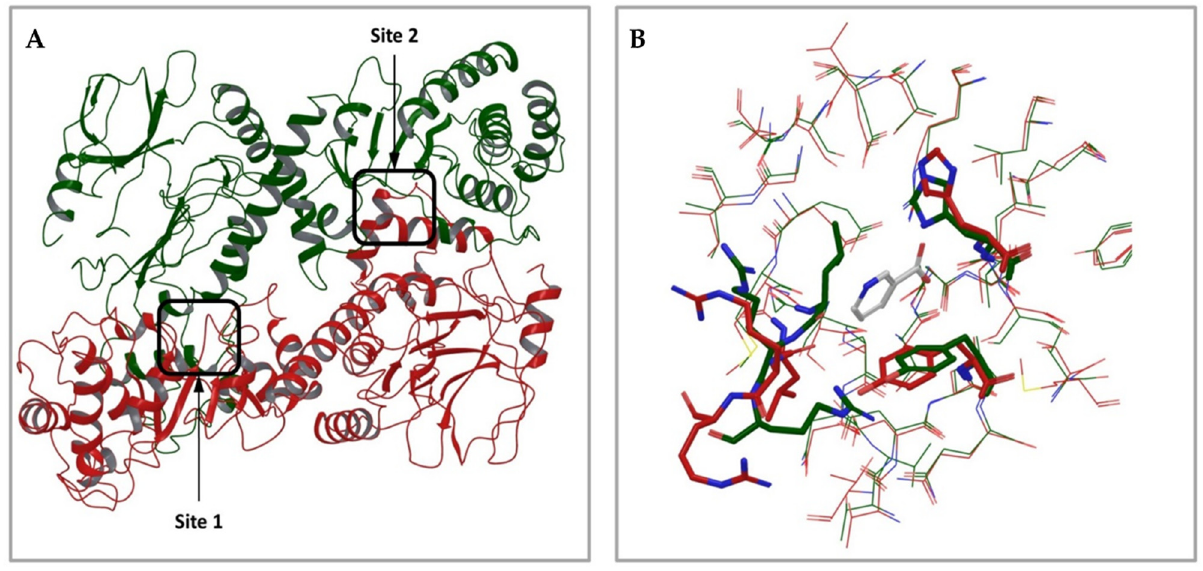
Figure 2. Analysis of the 3D structure of human NAPRT enzyme. ( A ) Overall oligomeric structure of human NAPRT. The enzyme has a dimeric structure and monomers A and B are colored in red and green, respectively. The two active sites are highlighted by black squares. ( B ) Structural superposition of the two active sites in the NAPRT dimer colored red and green, respectively; residues with relevant differences in conformation are drawn in thick tubes.